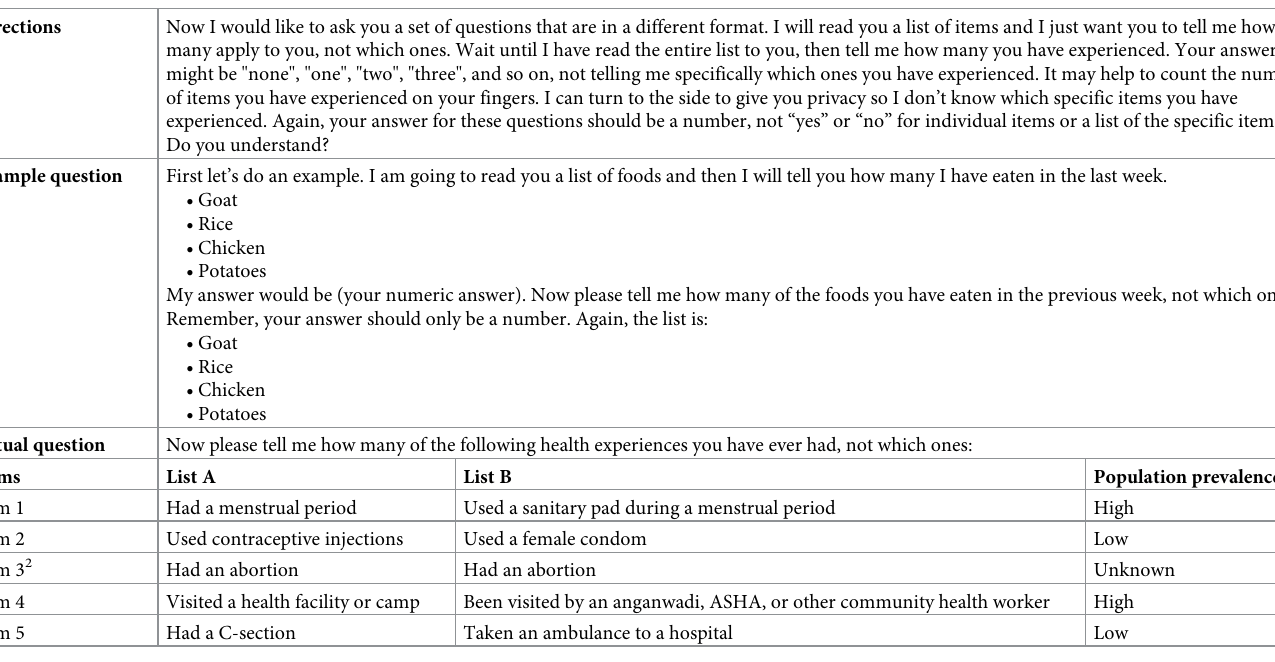
Table 1. Double list experiment directions, questions, and